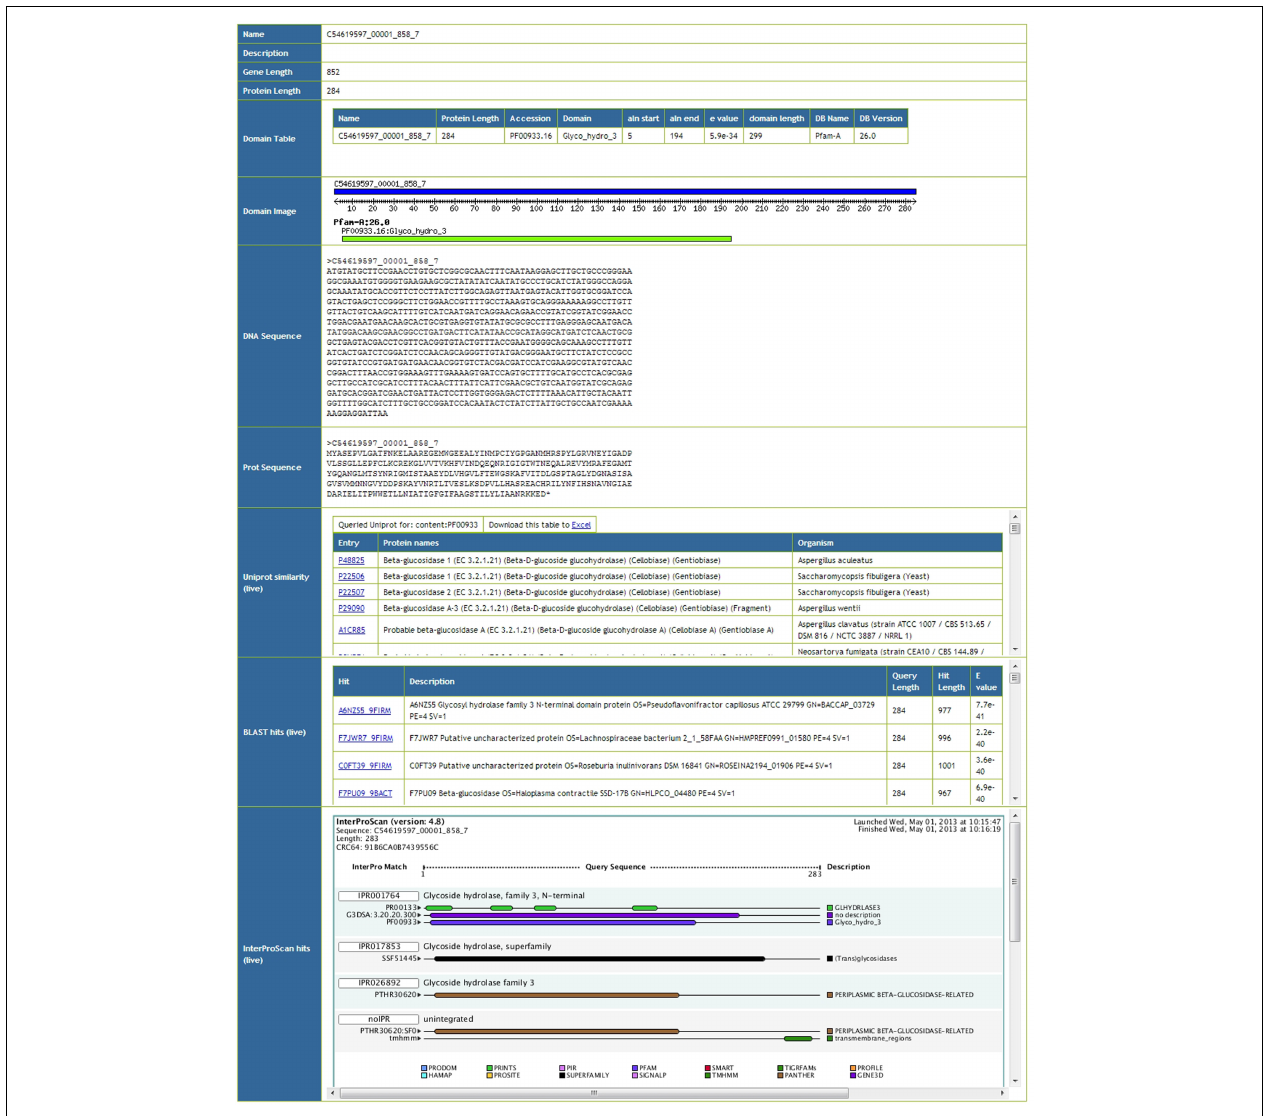
FIGURE 2 | Screenshot of the Meta4 results interface, showing information extracted from the Meta4 database, and information from web services (marked as “live” in the